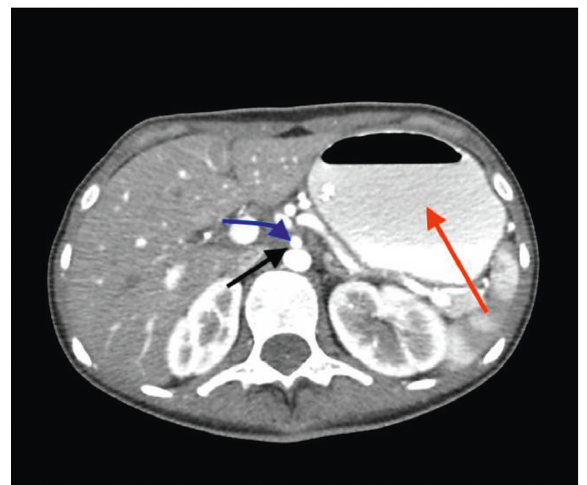
Figure 1: Axial CT abdomen showing compression of the third portion of the duodenum (black arrow) from the superior mes- enteric artery (blue), with distention of the stomach (red arrow).